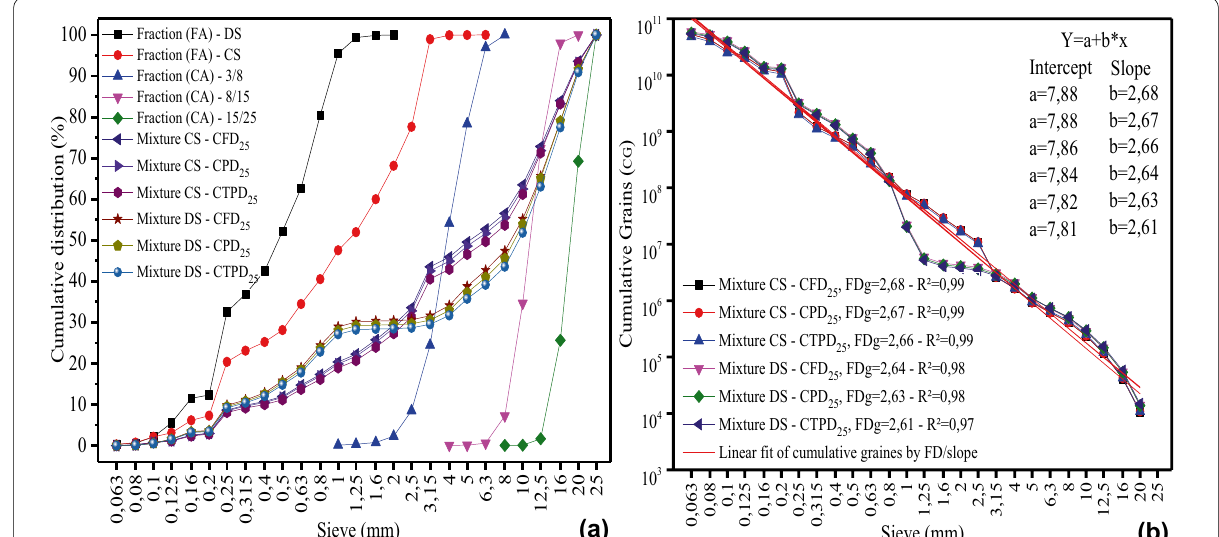
Fig. 4 Identifications of D 25 concrete granular curves using the fractal dimension FD g . a Granulometric curves, b fractal straight lines.